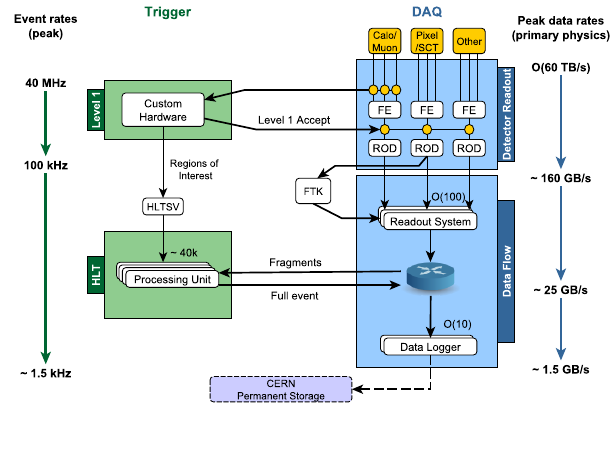
Figure 5. Diagram of the ATLAS Trigger and Data Acquisition system in Run 2